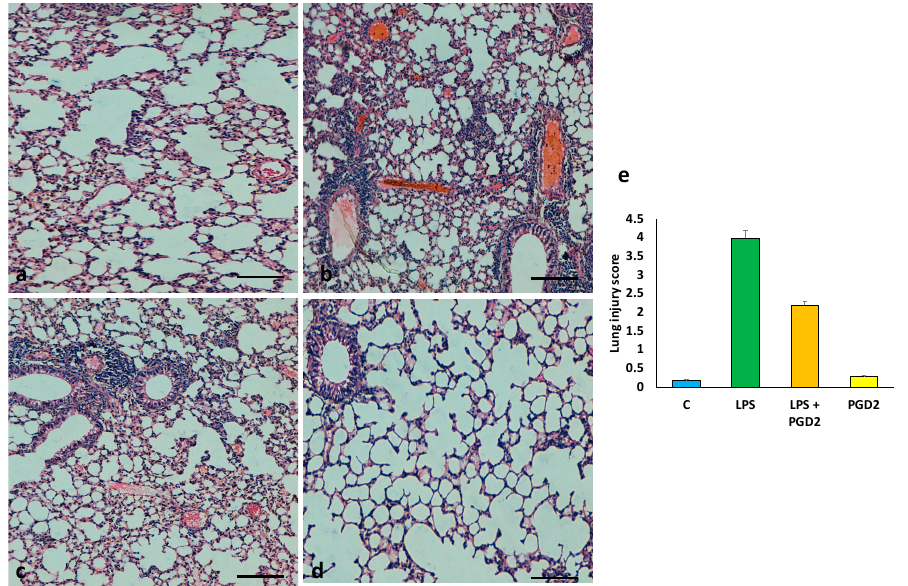
Figure 6. Histopathological analysis of lung tissue of mice models in different groups: ( a ) control animal group showing normal lung architecture, alveolar spaces, alveolar tissue, and normal bronchial and blood vessel patterns; ( b ) LPS-treated (5 mg/kg b.w.) animals demonstrating extensive destruction of alveolar architecture, infiltration of inflammatory cells, oedema, and congestion; ( c ) damaging alterations were significantly fewer with co-administration of PGD 2 (100 μ g/kg b.w.); ( d ) in the PGD 2 -only treatment group, lung tissues present normal architecture; ( e ) lung injury scores in different groups. (Scale bar = 100 μ m).